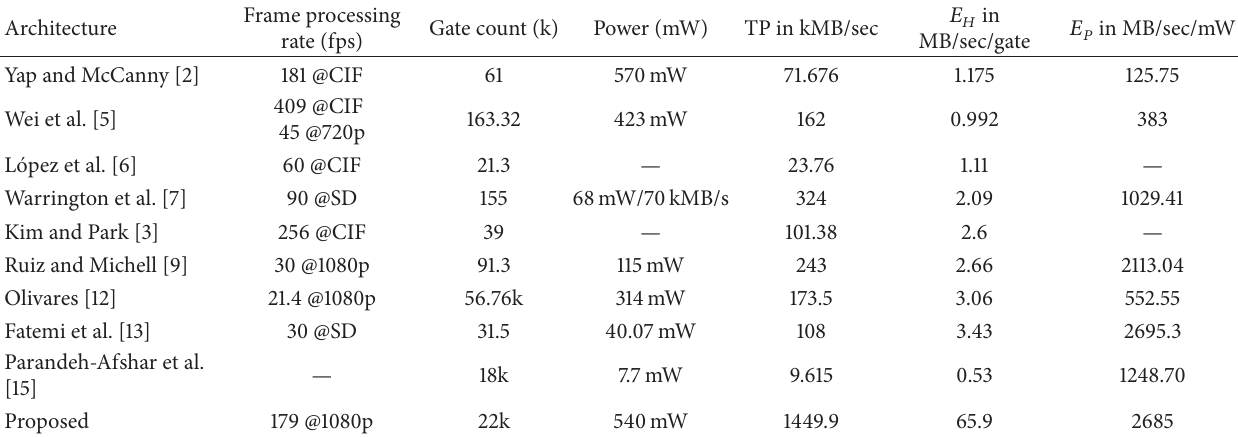
Table 6: Comparison of hardware and power efficiency for VBSME